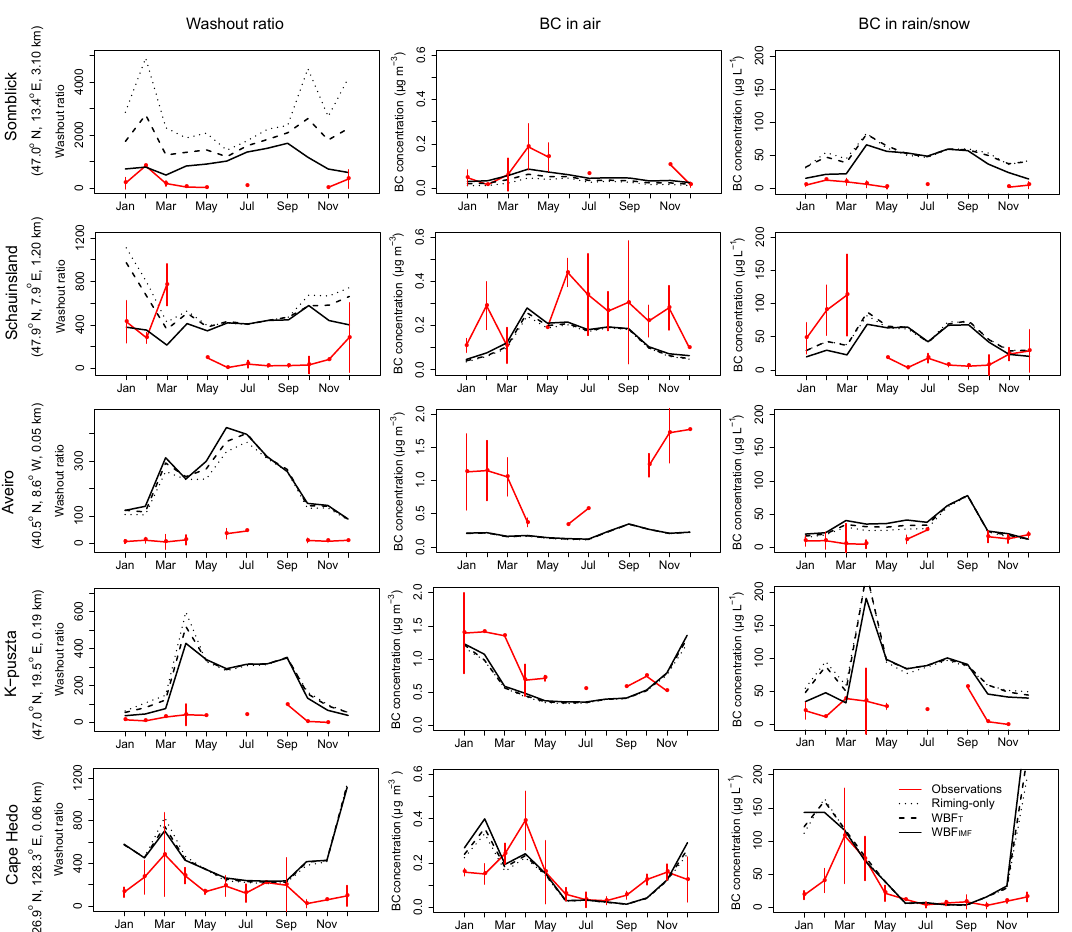
Figure 7. Observed and simulated BC washout ratio, BC concentration in surface air and in snow at Cape Hedo in the East China Sea, Aveiro and K-puszta (rural sites), and Schauinsland and Sonnblick (elevated